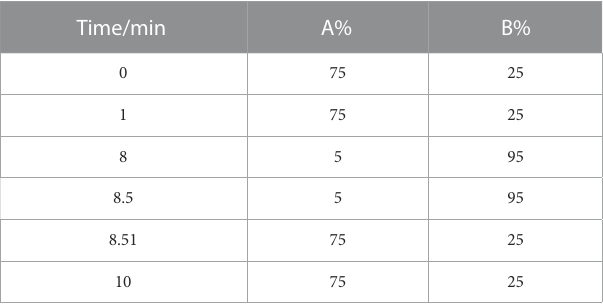
TABLE 1 Gradient elution program for LM